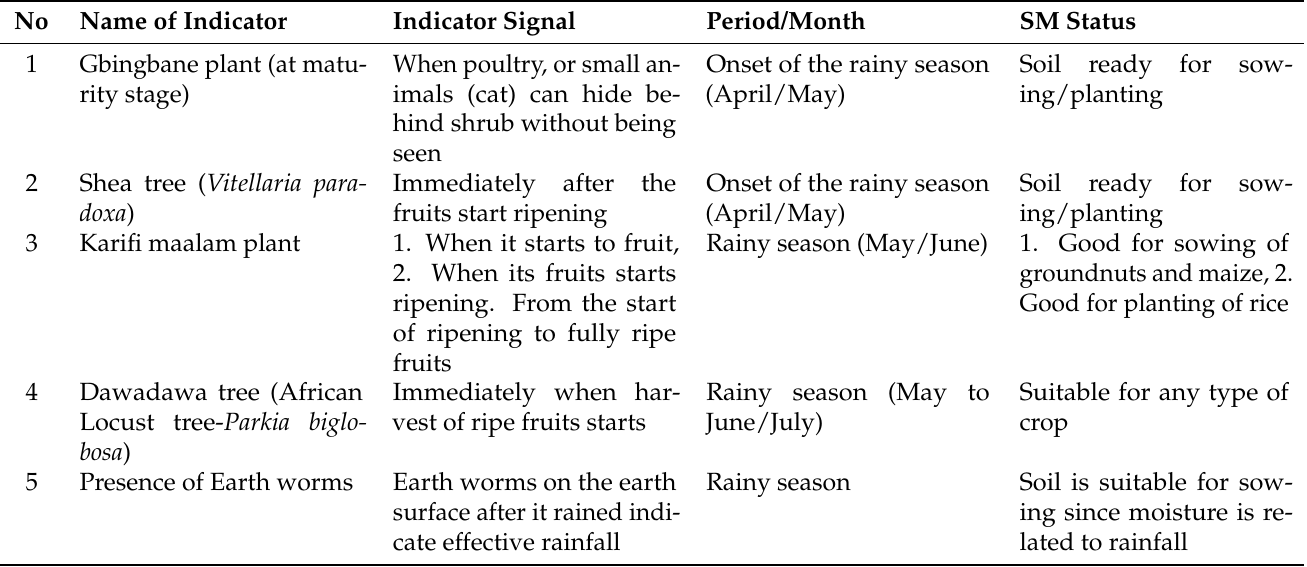
Table 3. Documentation of local indicators to monitor soil moisture